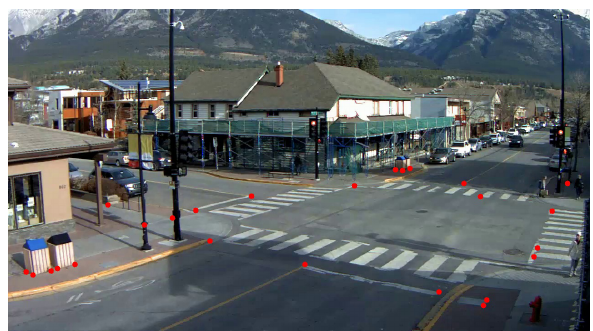
Figure 2. Homography points of the camera image